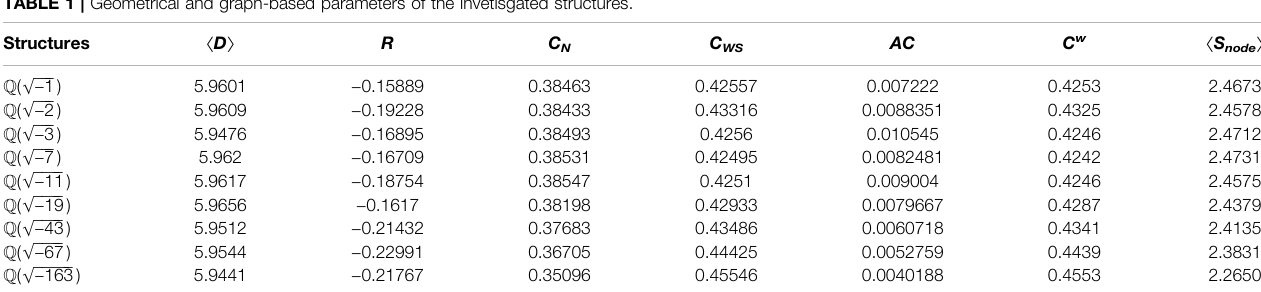
TABLE 1 | Geometrical and graph-based parameters of the invetisgated structures.